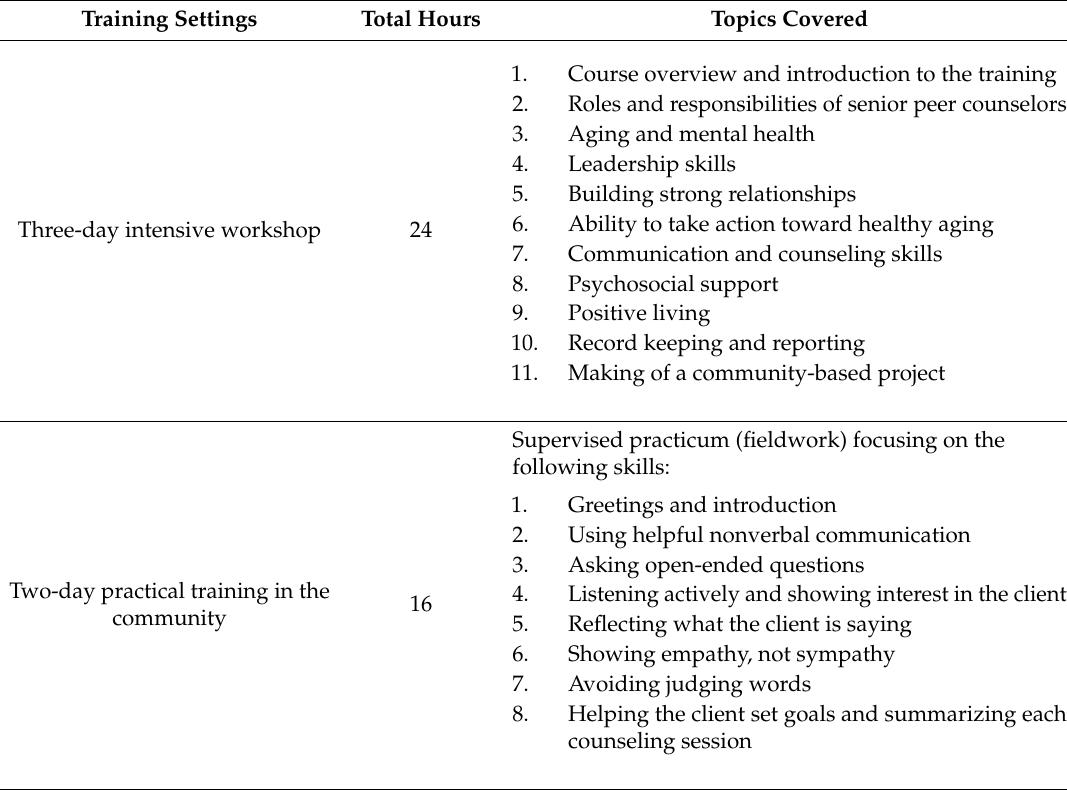
Table 1. Overview of training for leadership and peer counseling provided to peer